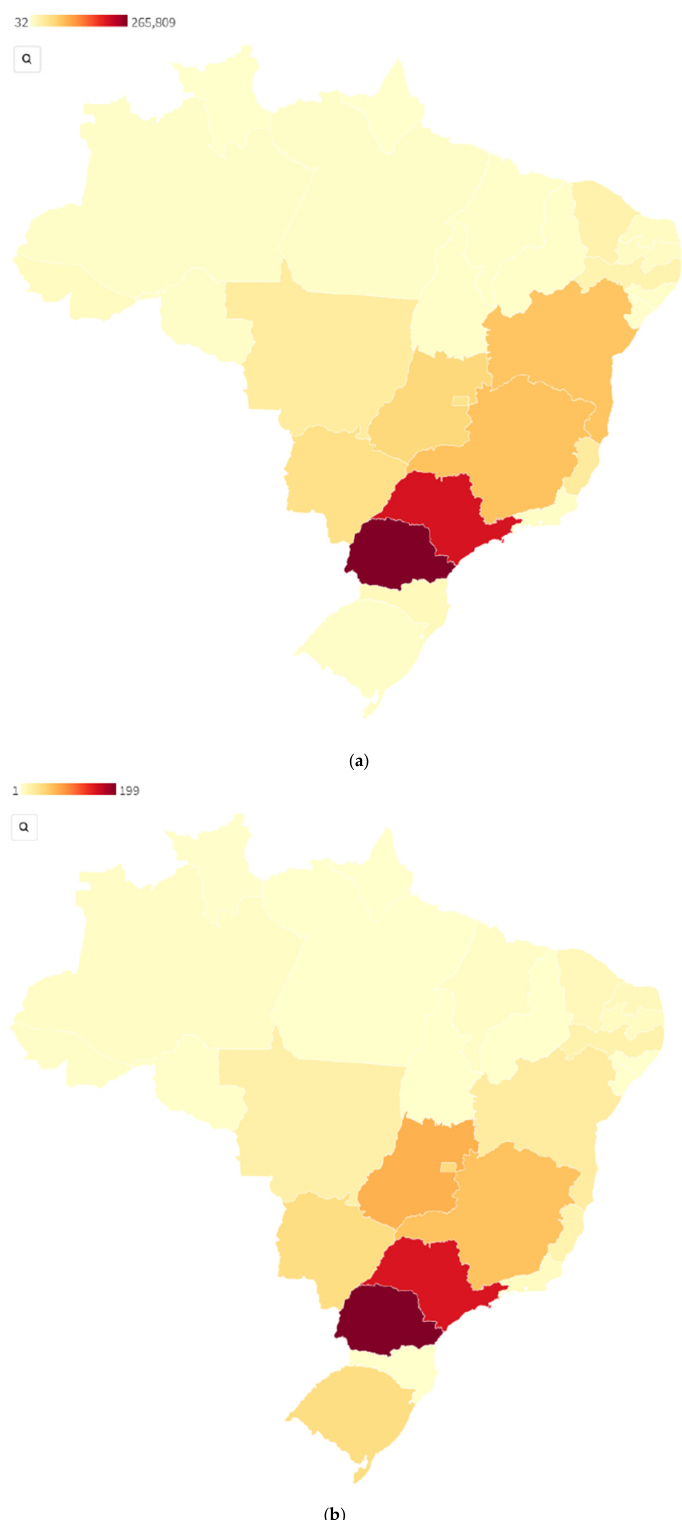
Figure 2. Probable dengue cases ( a ) [59] and confirmed deaths ( b ) [60] by state 2020, Brazil. Sources. Brazil has established a number of programmatic elements to manage emerging den ‐ gue cases. Dengue is a disease of compulsory notification in Brazil, which must be carried out through the Notifiable Disease Database ( Sistema de Informação de Agravos Notificáveis , SINAN), meaning each confirmed case is reported to municipal health units [61]. The Fed ‐ eral Ministry of Health also has an established Brazilian Dengue Control Program ( Pro ‐ grama Nacional de Controle da Dengue , PNCD). Additionally, Brazil has enacted legislation to integrate a legal framework into its vector management plan, allowing field activities to monitor and eliminate breeding sites [62]. Insecticide resistance is closely monitored, with the Ministry of Health purchasing insecticides and distributing them to municipali ‐ ties. At a community level, prevention and control programs have been implemented with mixed efficacy. A review of multiple case studies in Brazil has found that while knowledge of dengue among communities is satisfactory, this does not necessarily trans ‐ late into effective actions or entomological impact [63]. The Pan ‐ American Health Organization (PAHO) provided advice to member states to prevent and manage future outbreaks, including strengthening disease surveillance systems and laboratory capacity for diagnosis. In retrospect, and with the experience of COVID ‐ 19, it is clear that testing capacity was not bolstered enough in response to deal with future emerging threats. In contrast, the SINAN notification system has been instru ‐ mental in data collection and formed the basis for COVID ‐ 19 data collection. While den ‐ gue outbreaks have not been experienced on the same level as COVID ‐ 19, there are similar